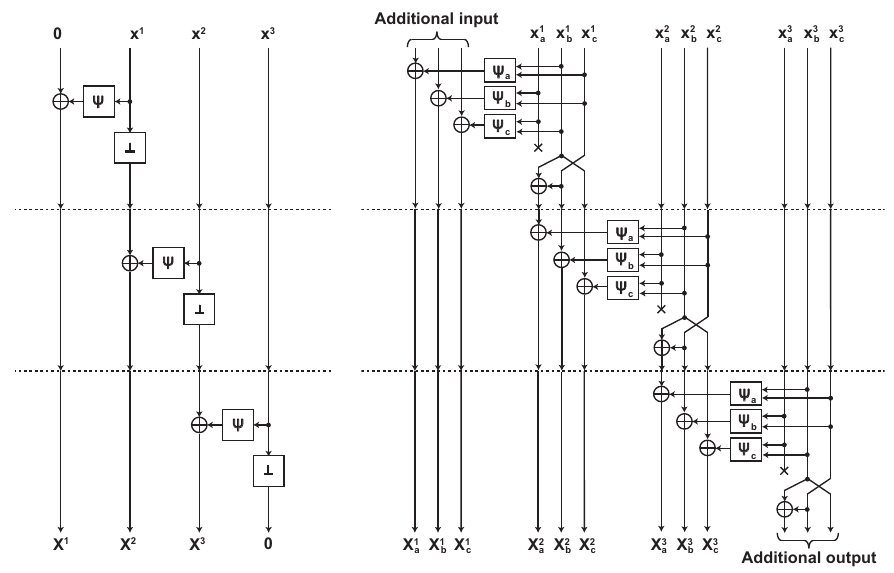
Figure 5: Cascaded ψ R (left) and its sharing